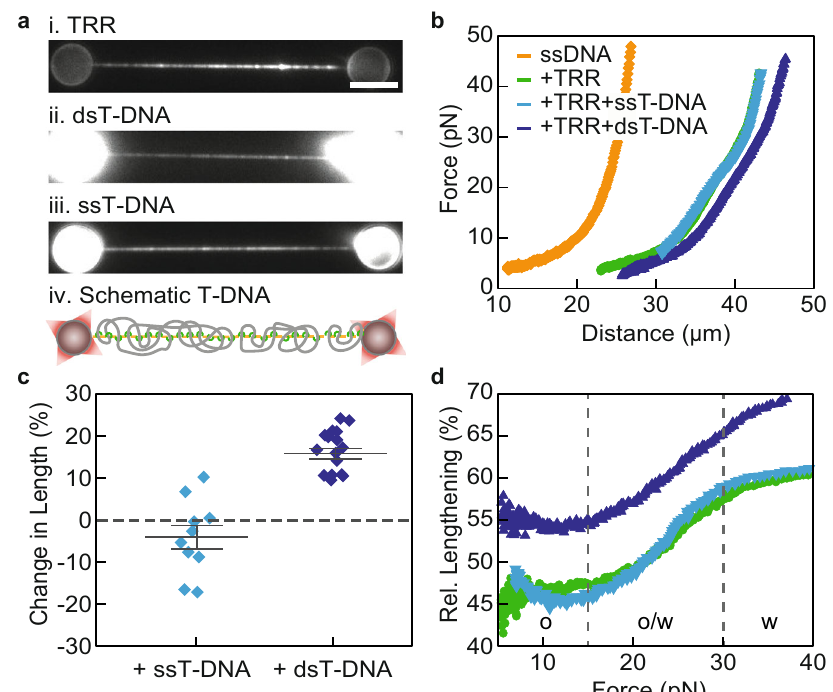
Fig. 3 Direct observation of ds/ssT-DNA binding to TRR-ssDNA. a Representative fl uorescence images (from N ≥ 10) of TRR-ssDNA (i) bound by either dsT-DNA (ii) or ssT-DNA (iii). TRR was visualized using mCherry fl uorescence, while dsT- and ssT-DNA were stained with intercalator dye. Note that images i and ii correspond to the same substrate (the TRR-mCherry fl uorescence image corresponding to the substrate in iii is not shown). A schematic representation of ssDNA coated with TRR and T-DNA is shown underneath (iv). Scale bar represents 5 µ m, and applies to all snapshots. b Representative FD-curves (from N ≥ 10) of bare ssDNA (orange), TRR-ssDNA (green) and TRR-ssDNA bound by either dsT-DNA (dark blue) or ssT-DNA (light blue). c Change in length of TRR-ssDNA (in the force range from 5 to 15 pN) upon binding of either ssT-DNA (light blue, from N ≥ 10) or dsT-DNA (dark blue, from N ≥ 10). Error bars indicate SEM. d ‘ Subtraction plots ’ showing the relative (rel.) lengthening for TRR-ssDNA (green), and TRR-ssDNA bound by either ssT-DNA (light blue) or dsT-DNA (dark blue) compared to bare ssDNA. Plots were generated using the FD-curves in panel ( b ). Dashed grey lines highlight the transition (o/w) between the open (o) and the widened (w) states of the TRR-ssDNA gate. Source data are provided as a Source Data fi